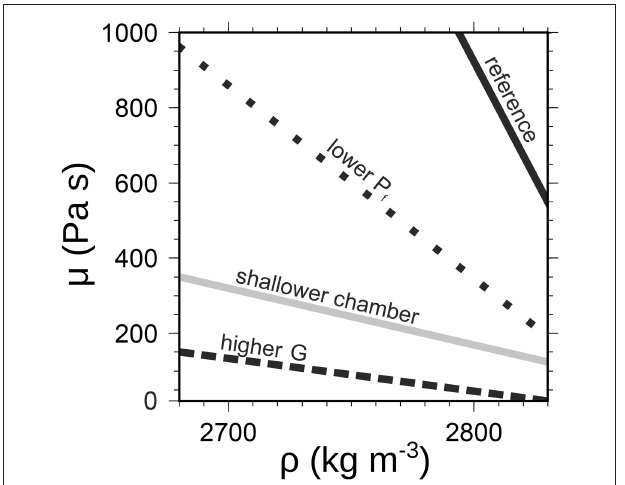
FIGURE 5 | Results of constant volumetric influx rate models. Lines show boundary between density-viscosity corresponding to no predicted eruption (top right) and predicted eruption (bottom left). The solid black line shows an arbitrary reference set of conditions, with magma chamber depth at h = 20 km, P f = 5 MPa, and G = 25 GPa. Note that eruption is expected for a wide range of magma densities and viscosities from this chamber. The other lines show the effect of varying the parameters individually, all in a sense which reduces the range of melt densities and viscosities that can be erupted. Dotted black line: effect of reducing P f to 4 MPa, with all other parameters set at the reference values. Solid gray line: effect of setting h = 10 km with all other parameters set at the reference values. Dashed black line: effect of increasing G to 50 GPa, with all other parameters set at the reference